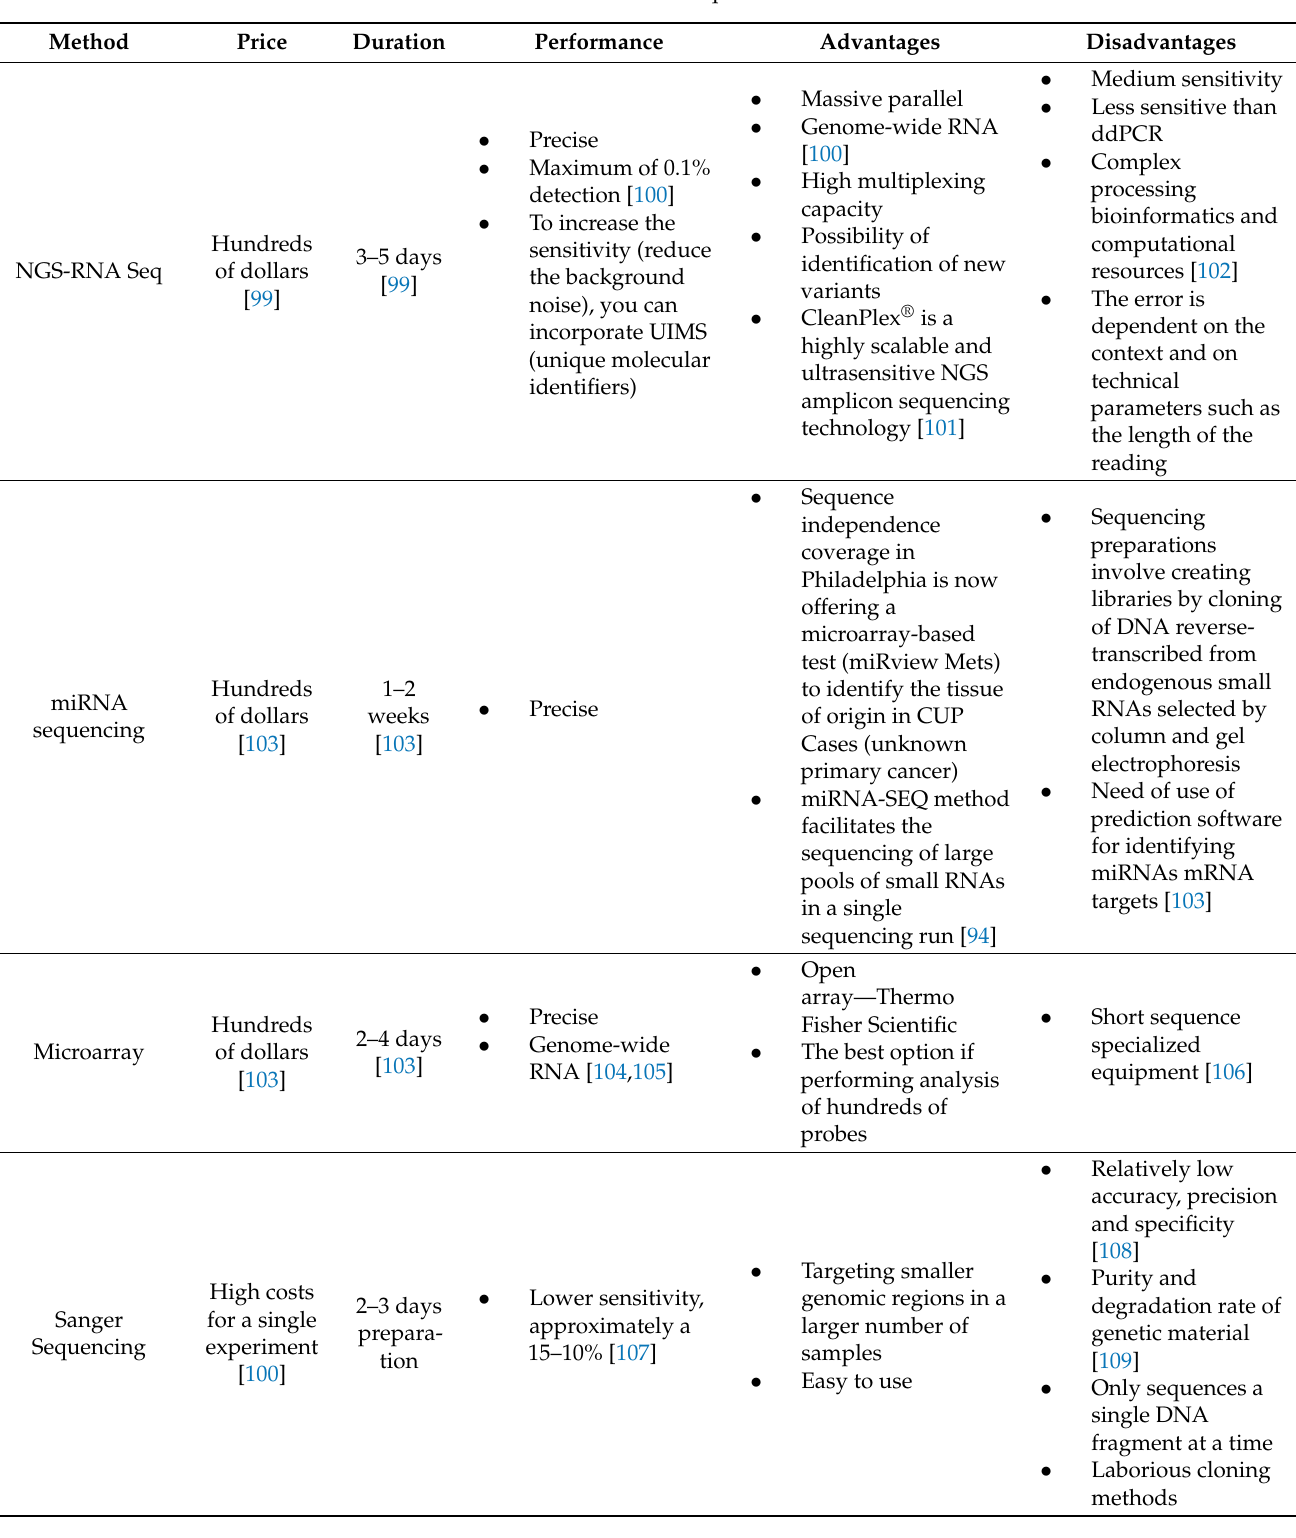
Table 4. Methods for RNA